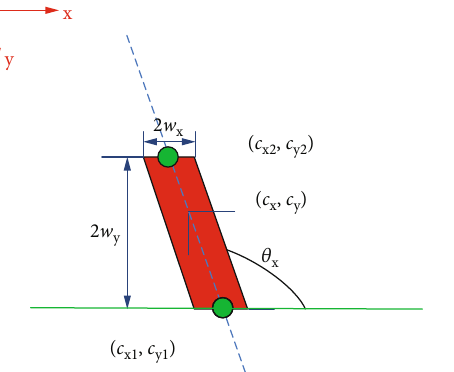
Figure 3: The surface of the volume source is not parallel to the reservoir